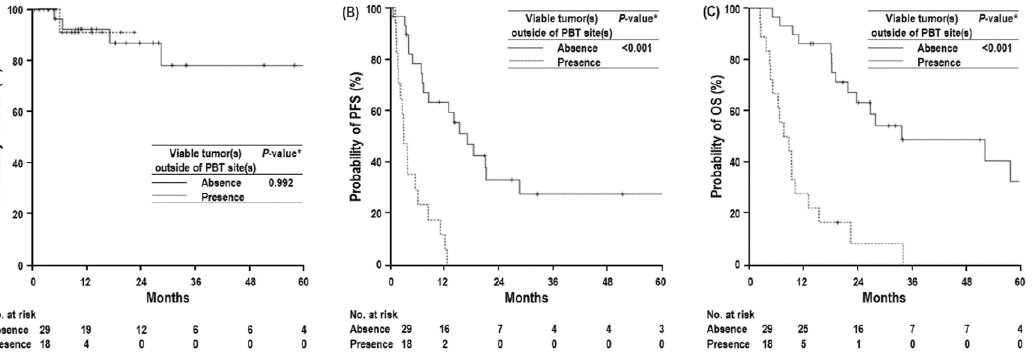
Figure 2. Freedom from local progression (FFLP) ( A ), progression-free survival (PFS) ( B ), and overall survival (OS) ( C ) 0 curves according to absence or presence of viable tumor(s) outside of PBT site(s). Abbreviations: PBT, proton beam therapy. * log-rank